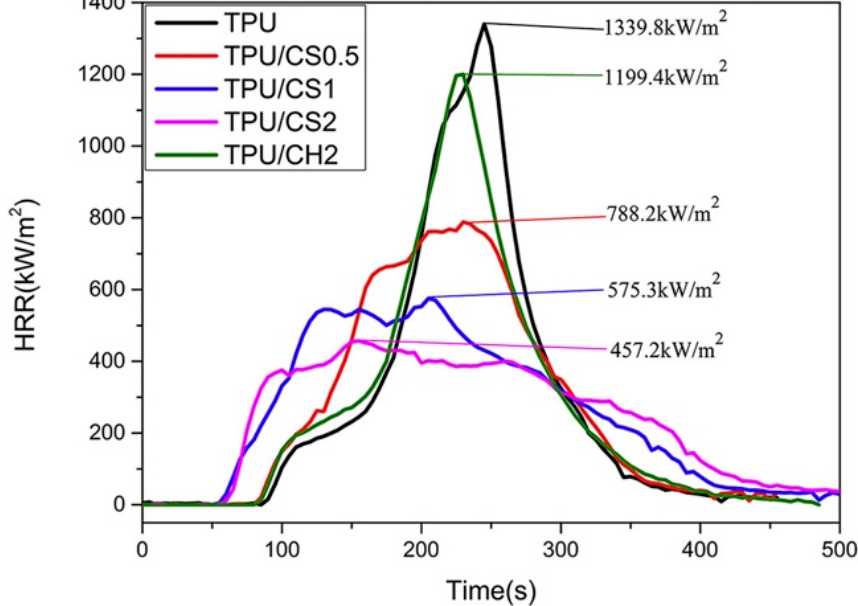
Figure 7. Heat Release Rate (HRR) vs. time curves of flame retardant thermoplastic polyurethane